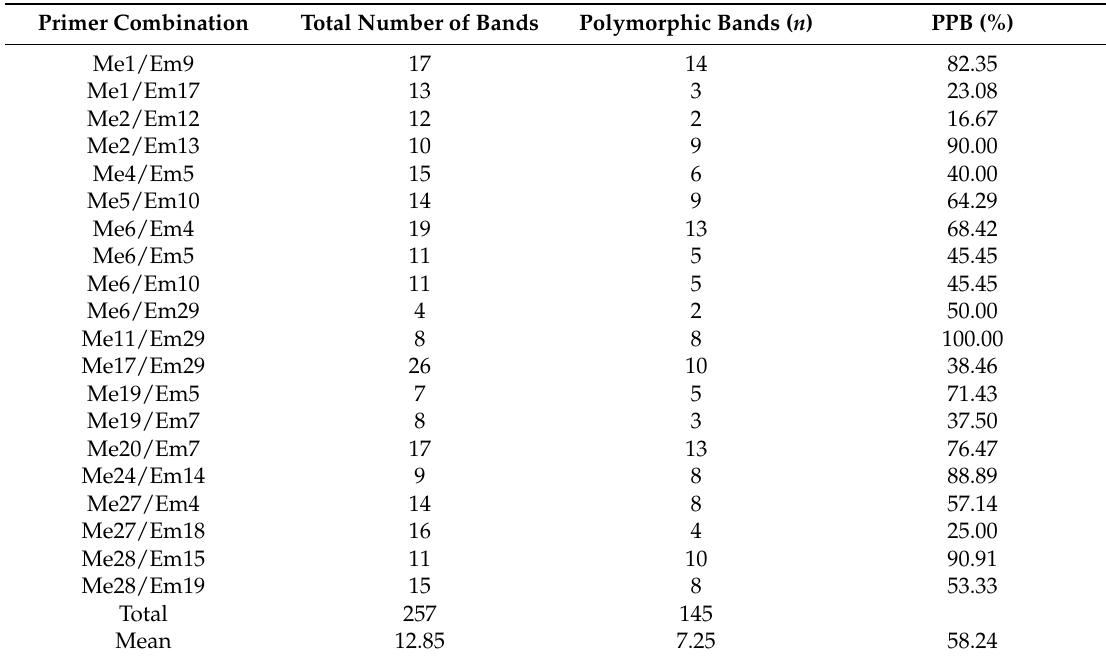
Table 3. Polymorphism data based on genetic analyses performed using 20 SRAP primer combinations. Primer